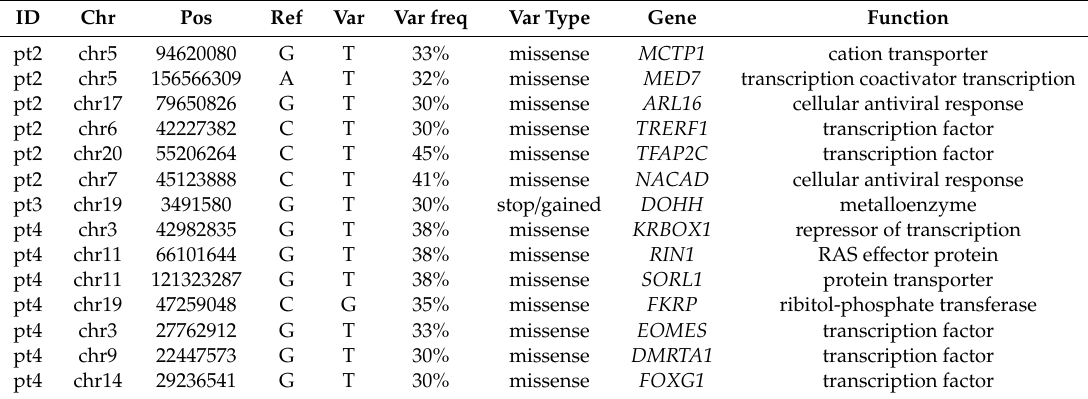
Table 3. Somatic variants detected by WES in primary TGCT tumors (in comparison with germ-line control patient